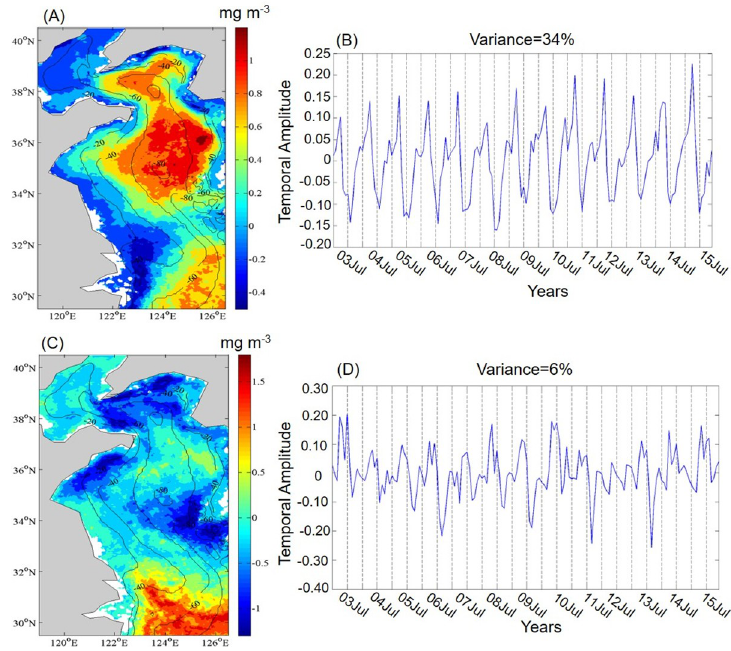
Fig 4. Variability in Chl- a during 2003–2015 in the Yellow Sea, China. (A) Spatial pattern and (B) temporal amplitude for the first EOF mode, (C) spatial pattern and (D) temporal amplitude for the second EOF mode.